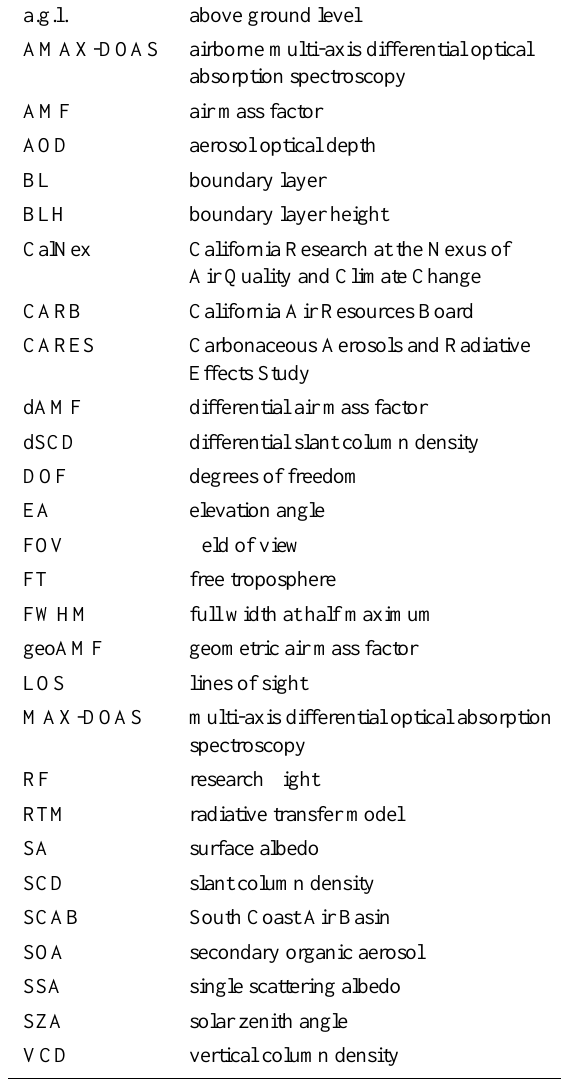
Table A1. List of frequently used